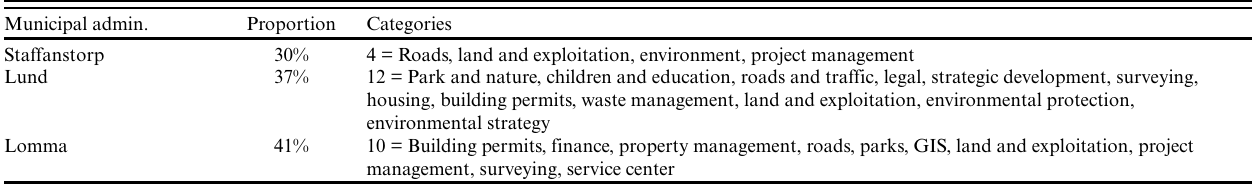
Table 2 . Proportion and categories of other civil servants, not primarily engaging in planning, water and sewage, or risk and vulnerability activities.